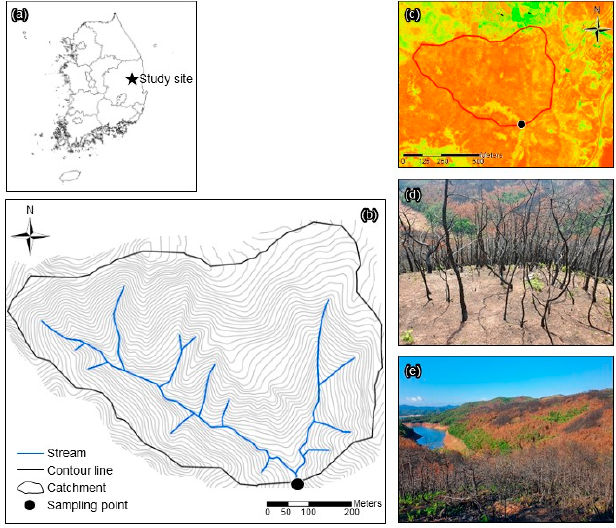
Figure 1. ( a ) Location of study site and ( b ) sampling point. ( c ) Normalized Difference Vegetation Index (NVDI) in the study catchment on 17 August 2021. Images ( d , e ) overview of the study catchment after the forest fire.